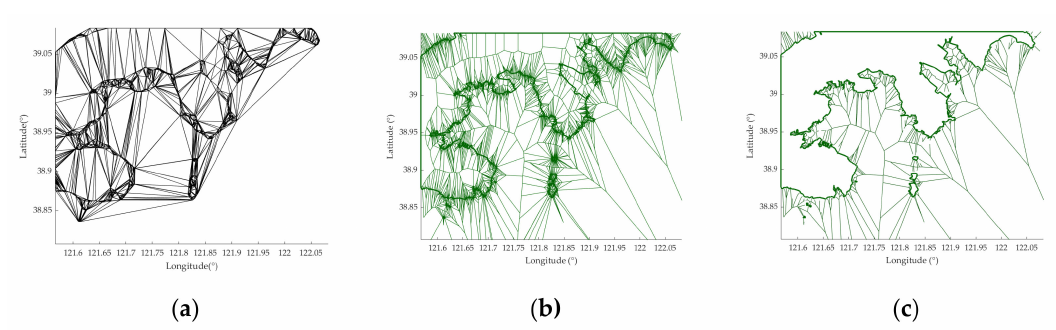
Figure 8. Voronoi graph generation: ( a ) represents Delaunay triangulation; ( b ) represents the Voronoi roadmap. ( c ) Collision-free